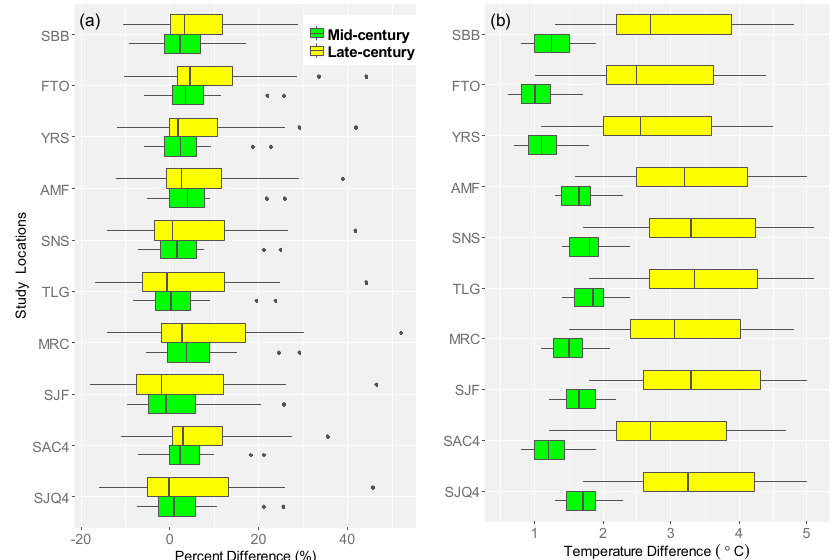
Figure A4. Monthly mean runoff projections for ( a ) Stanislaus River, ( b ) Tuolumne River, ( c ) Merced River, and ( d ) San Joaquin River under RCP 4.5 and RCP 8.5 projections, respectively.